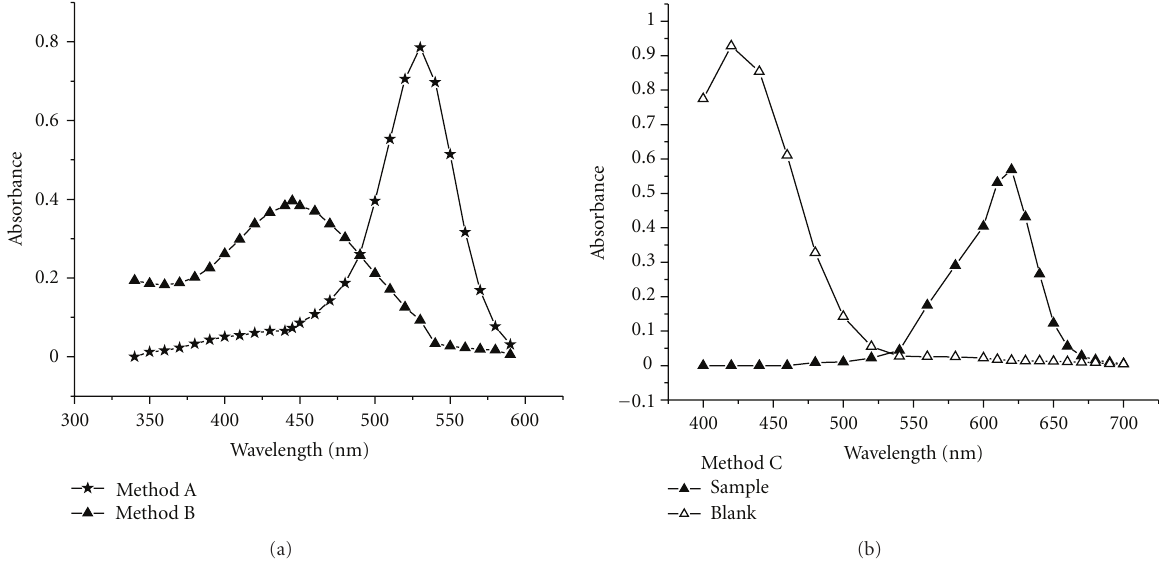
Figure 1: Method A: 1 mL 80 μ g/mL MCP; 2mL 5M HCl. Method B: Brominated product of MCP (1mL 40 μ g/mL bromated-bromide mixture; 2mL 5M HCl; 1mL 80 μ g/mL MCP). Method C: Sample: 1mL 40 μ g/mL ATN; 5 mL 1M HCl; 1 mL 18 μ g/mL